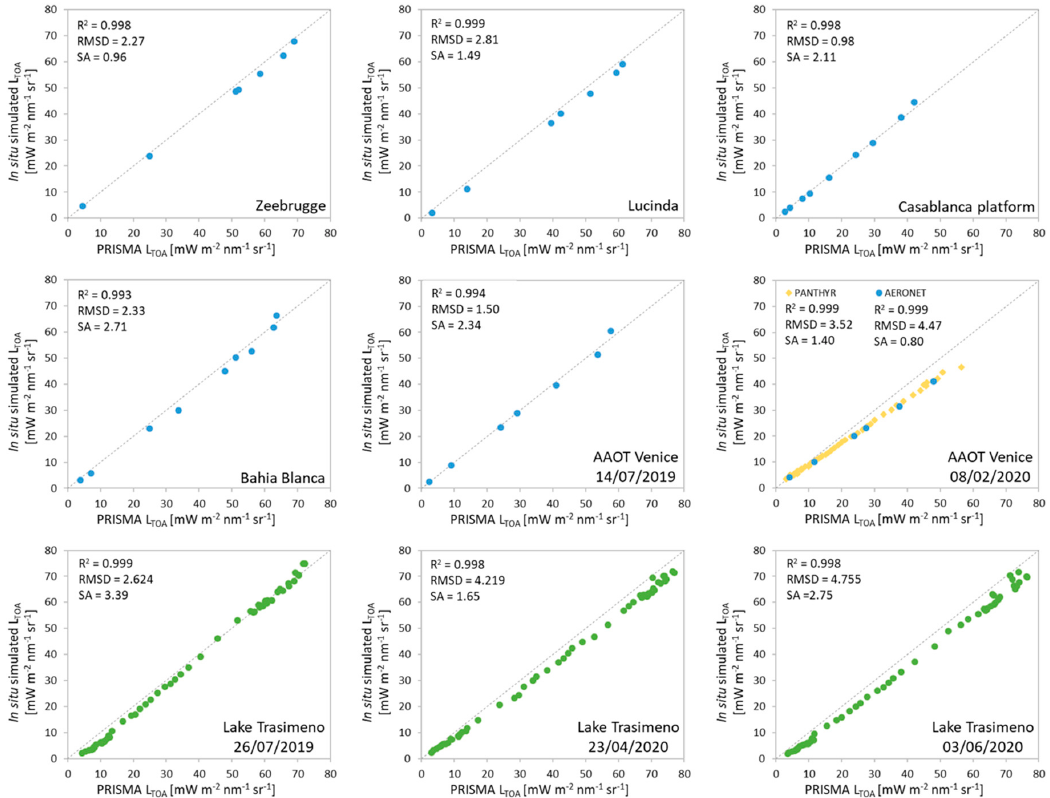
Figure 3. Scatterplots of TOA radiances from PRISMA (x-axis) vs. 6SV simulations (y-axis) for common bands. Blue dots are indicating the comparison for AERONET-OC sites, green for WISPStation and yellow for PANTHYR. Sensors 2020 , 20 , x FOR PEER REVIEW